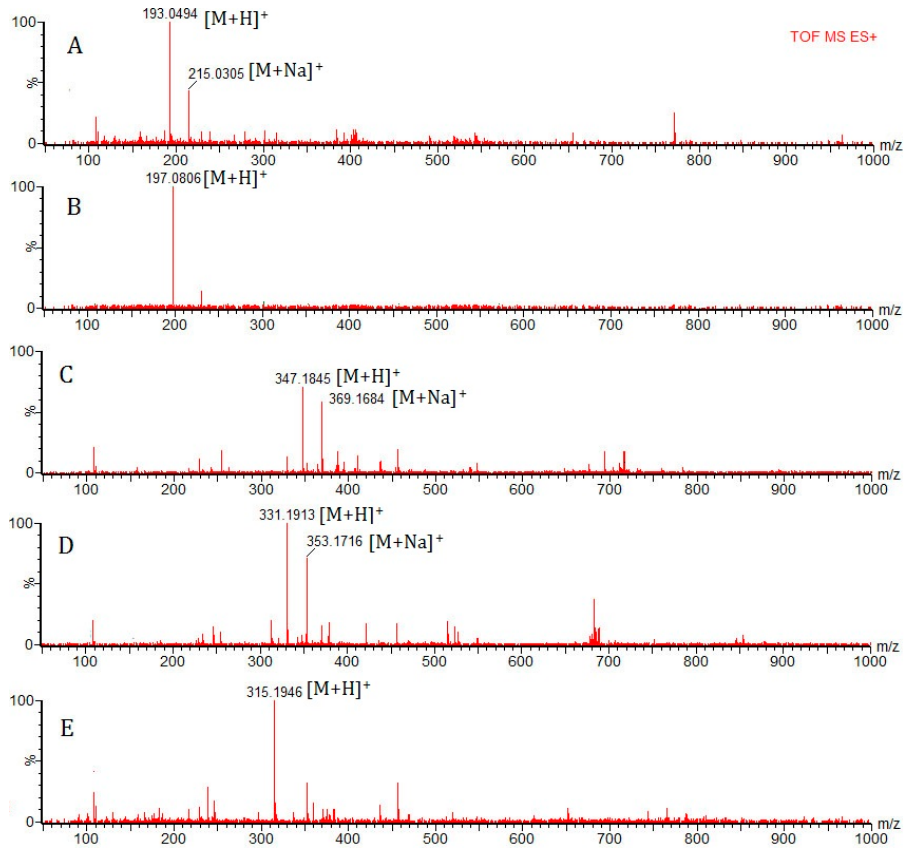
Figure 5. Extracted ion chromatogram (EIC) of five compounds from Euphorbia fischeriana for quantification: ( A ) Scopoletin with [M + H] + and [M + Na] + peak; ( B ) 2, 4-Dihydroxy-6-methoxy-3-methylacetophenone with [M + H] + peak; ( C ) 17-Hydro xyjolkinolide B with [M + H] + and [M + Na] + peaks; ( D ) Jolkinolide B with [M + H] + and [M + Na] + peaks; and ( E ) Jolkinolide A with [M + H] + peak.